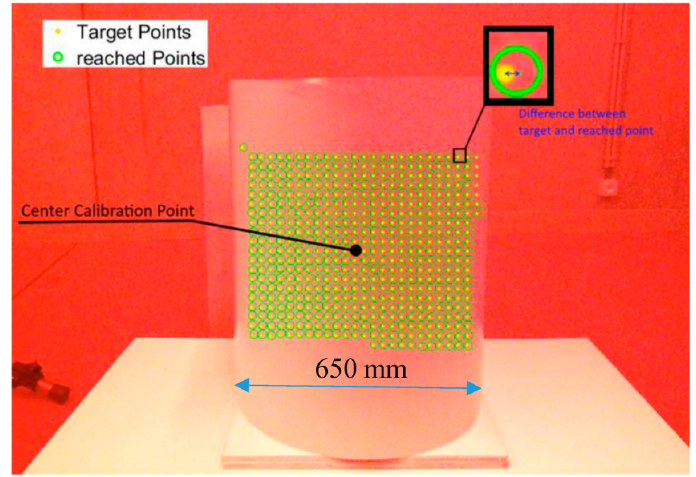
Figure 9. Example of the target and reached points on a cardboard barrel with the 3D method. Detected/reached points are defined by circles, target points by points. Some points were not